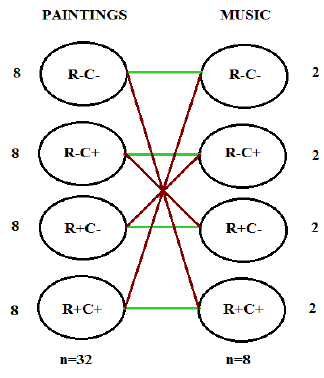
Figure 1. Four groups of visual and music stimuli based on regularity/complexity combination; green (parallel) lines represent congruent conditions, whereas, red (crosswise) lines represent incongruent conditions.